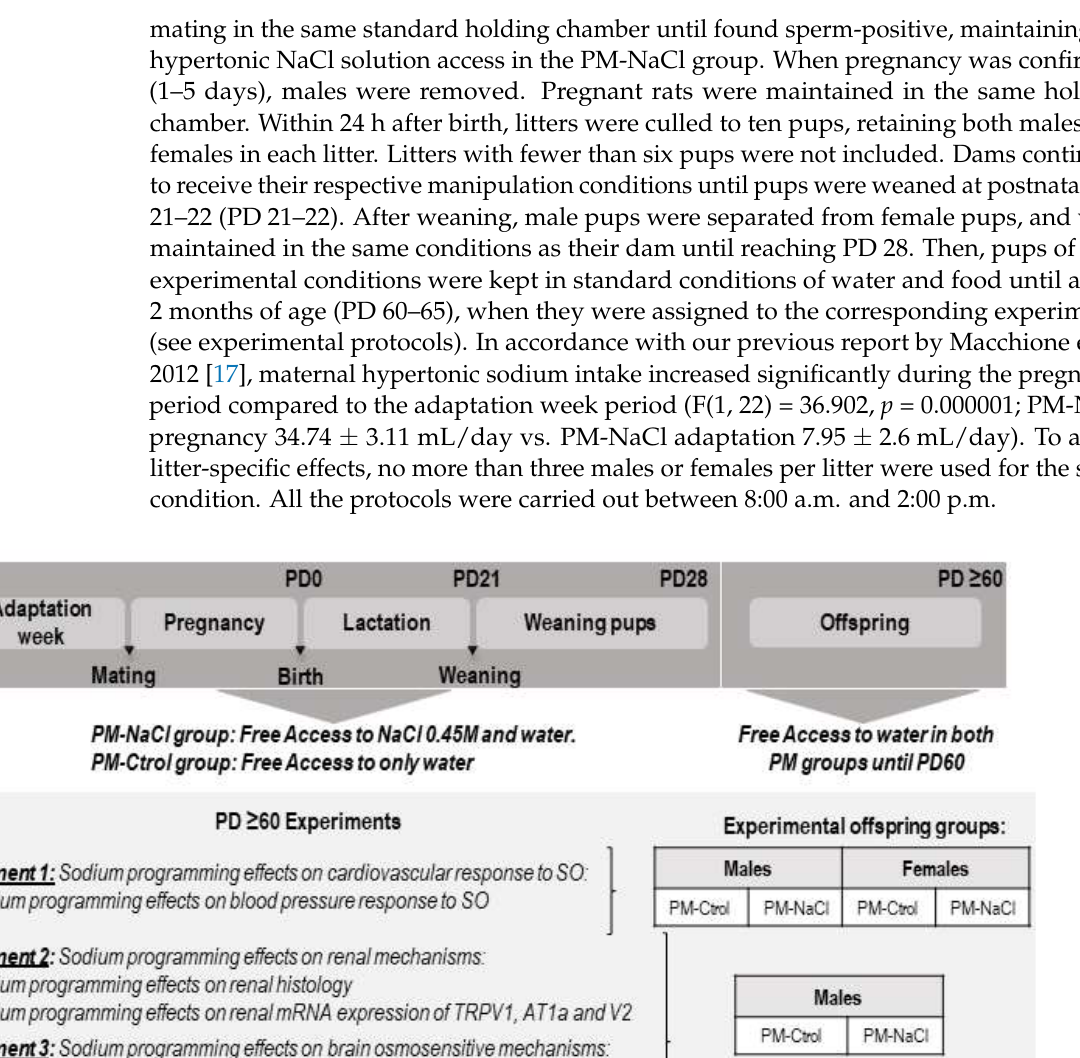
3 of 16 before mating, female rats were randomly divided in two groups to receive each perinatal